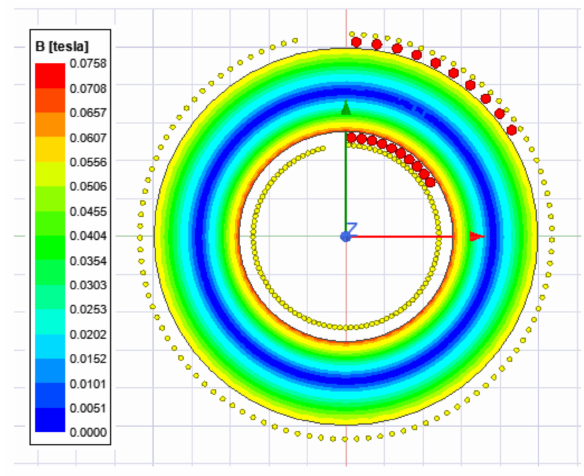
Figure 9. Magnetic field density on transformer core. The magnetic field strength is also determined by the research study. Figure 10a depicts a high magnetic field at the core, whereas Figure 11 depicts homogenous magnetic flux lines. Excessive stress and strain on the winding is obvious from Figure 10b, which can cause insulation to degrade or even deform [32], whereas the toroidal transformer showed less winding stress compared to the shell-type.